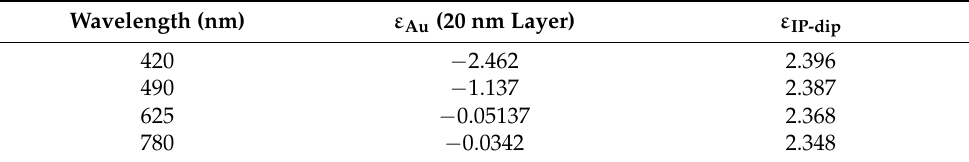
Table 1. Comparison of real permittivity of thin gold layer and IP-Dip photoresist at different wavelengths. Wavelength (nm)